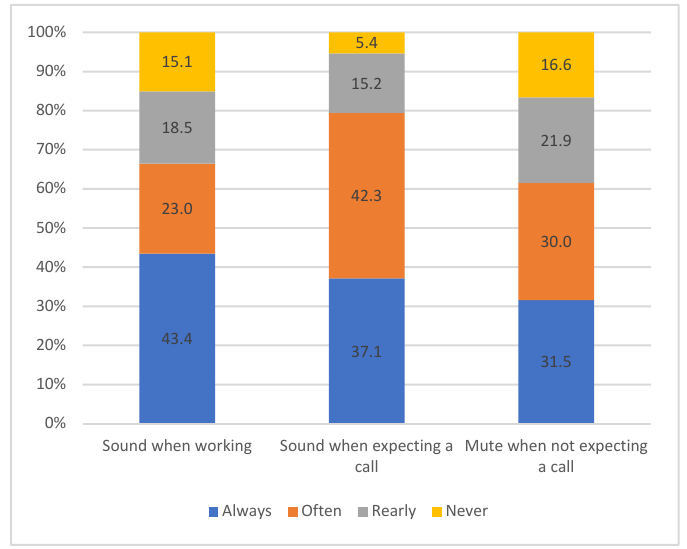
Figure 9. Phone range at work.